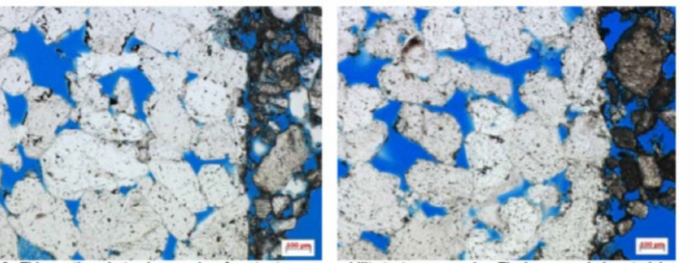
Figure 17. Photomicrograph showing thin-section analysis results for post-formation-damage testing of rock material using drilling fluid with optimised bridging particles. The brown or dark substance on the right side of each micrograph is filter cake [73].